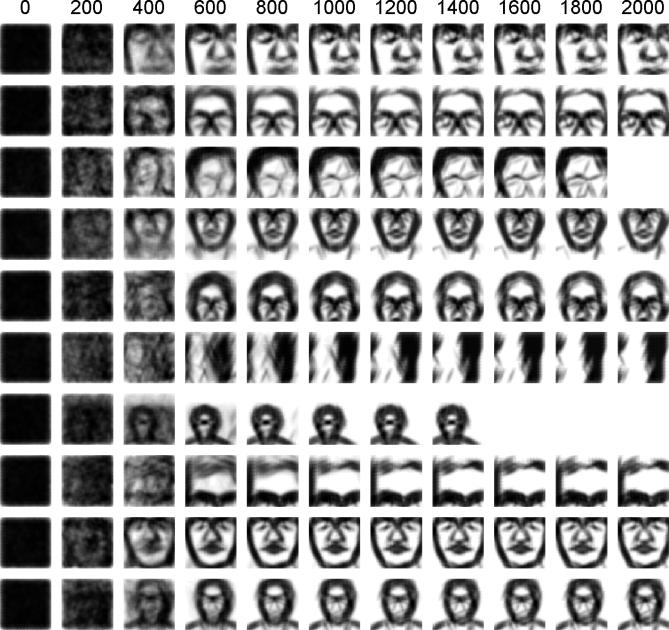
Evolution of Reconstructions for Face FeaturesAt the top is the number of postsynaptic spikes emitted. Starting from random preferred stimuli, cells detect statistical regularities among the input visual spike trains after a few hundred discharges and progressively develop selectivity to those patterns. A few hundred more discharges are needed to reach a stable state. Furthermore, the population of cells self-organizes, with each cell effectively trying to learn a distinct pattern so as to cover the whole variability of the inputs.